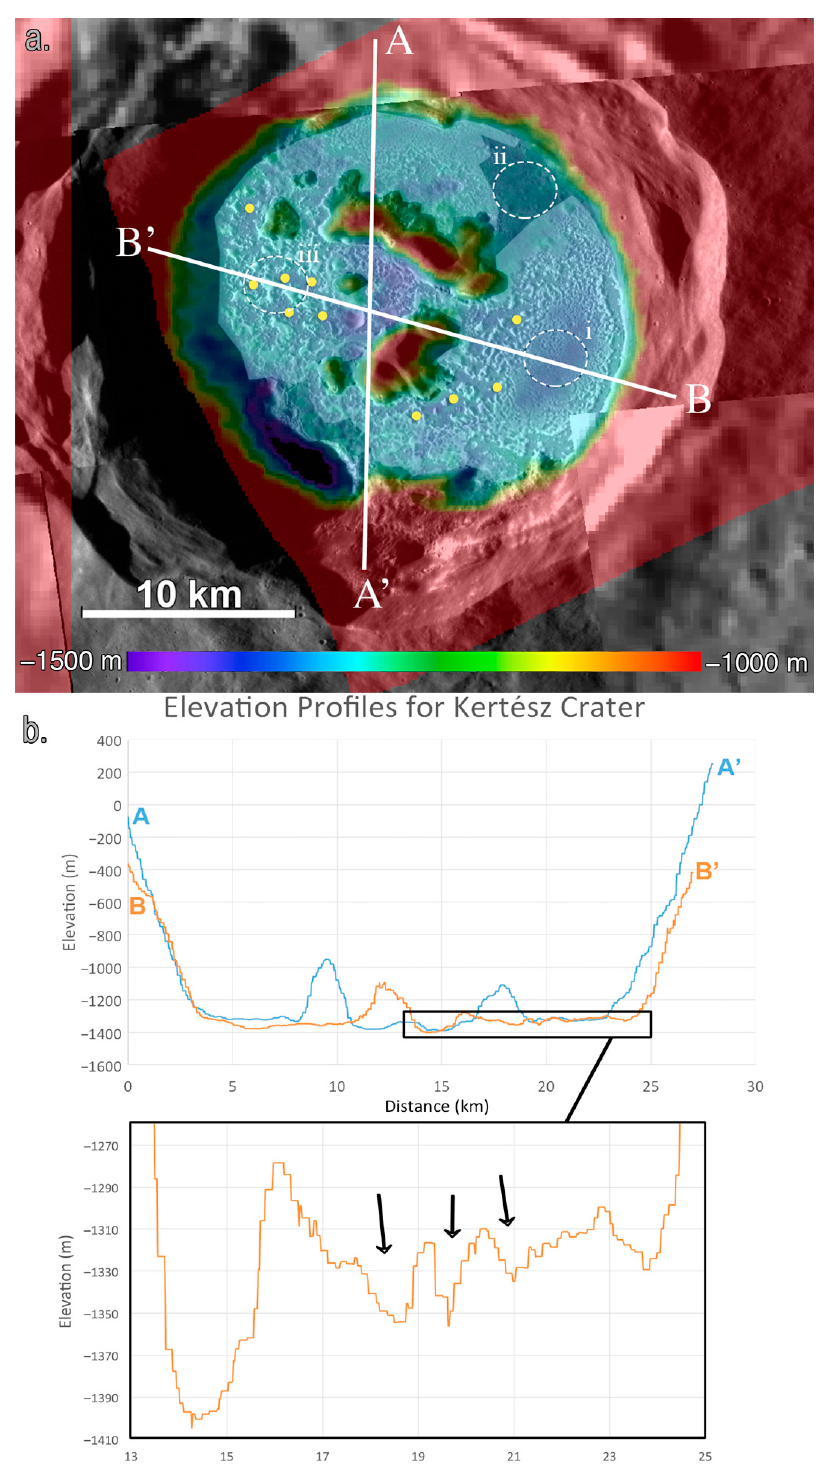
Figure 11. ( a ) Kertész crater orthophoto overlaid with a color-shaded elevation map. Polygons show hollowed areas of floor investigated here; dotted circles mark characteristic units of pitted terrain (i), smooth floor (ii), and bright knob/deep floor (iii). Yellow dots indicate ten hollows measured for this study. See Appendix A for stereo pair details. ( b ) Elevation profiles. Inset profile shows a detail of bright knob/deep floor area; arrows indicate distinct